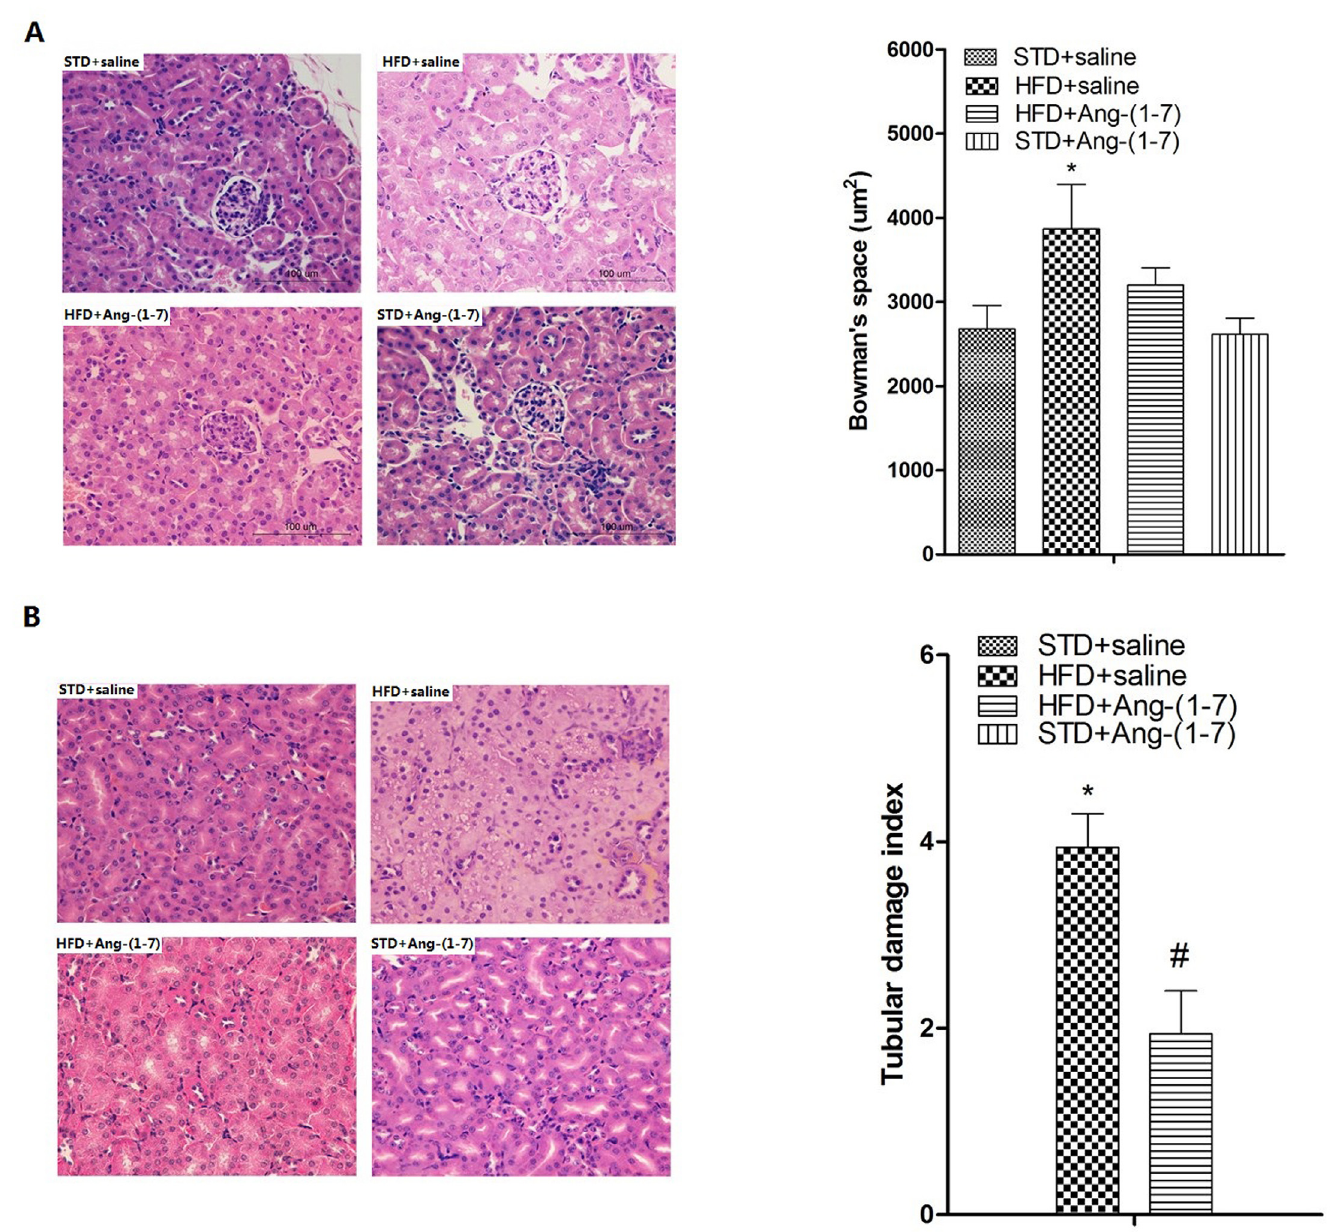
Fig 7. HE staining of a representative renal section. Ang-(1 – 7) improves HFD-induced glomerular and tubular damage. A: Images of glomerulus and representative quantitative analysis of Bowman ’ s space. Scale bar is 100 μ m. Values are expressed as means ± SD (n = 6) B: Images of tubules and representative quantitative analysis of tubular damage index. Original magnification 200×. Values are expressed as means ± SD (n = 6), * P <